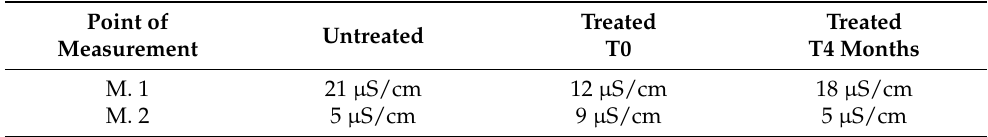
Table 5. Values of the conductivity before and after the consolidation treatment with aqueous nanolime in situ.